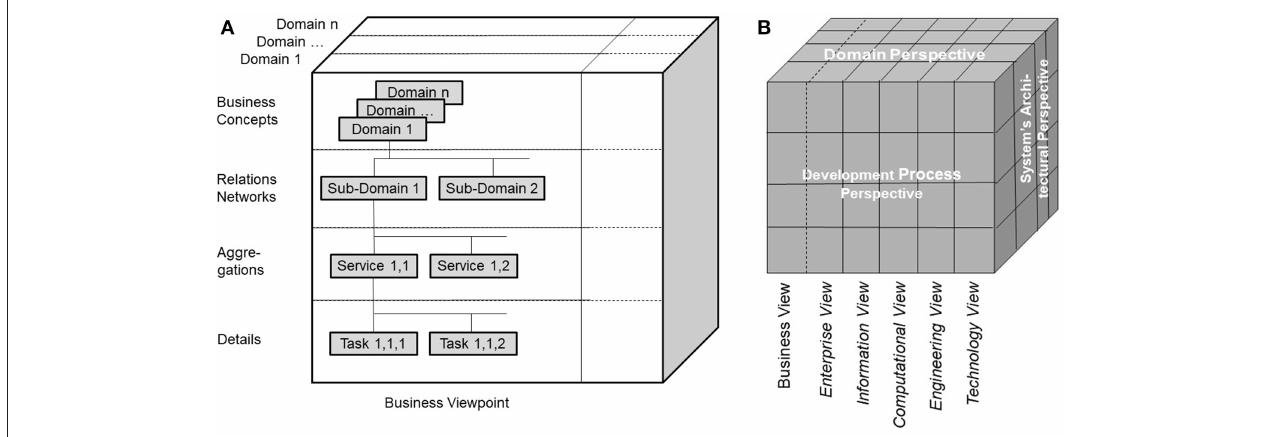
FIGURE 2 | (A) Architectural representation of pHealth ecosystems, (B) ISO Interoperability Reference